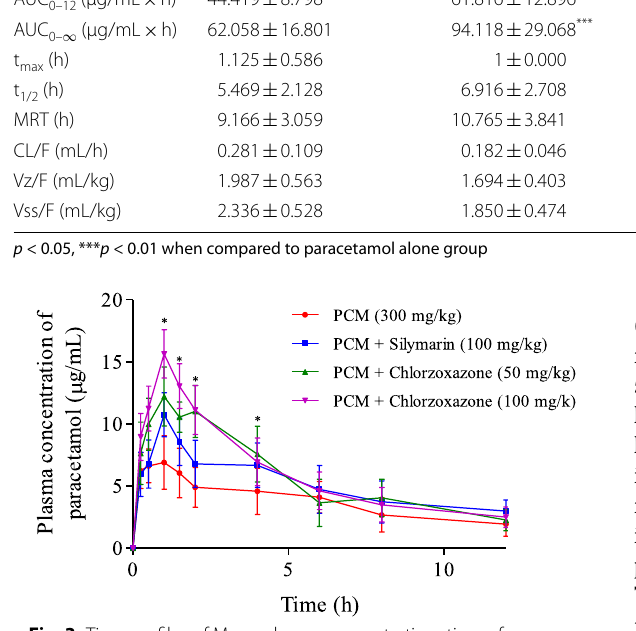
Fig. 3 Time profiles of Mean plasma concentration–time of Paracetamol; following an oral administration of Paracetamol to rats with or without diosmin (n 6). (Circles) Control (paracetamol); = (squares) with 100 mg/kg Silymarin and paracetamol (300 mg/kg); (traingles) with 50 mg/kg chlorzoxazone and paracetamol (300 mg/ kg); (inverted traingles) paracetamol with chlorzoxazone (100 mg/ kg). All values are mean SD. Bars represent the standard deviation. ± *P < 0.01, compared to the paracetamol control group (Two-way ANOVA followed by Bonferroni post-tests to compare each column to column). PCM,